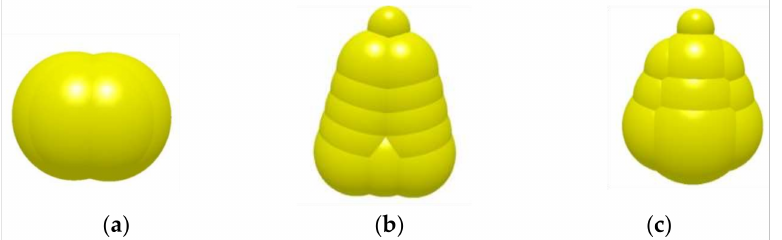
Figure 3. Simulation seed model. ( a ) Spheroid shape, ( b ) horse-tooth shape, ( c ) ellipsoid cone